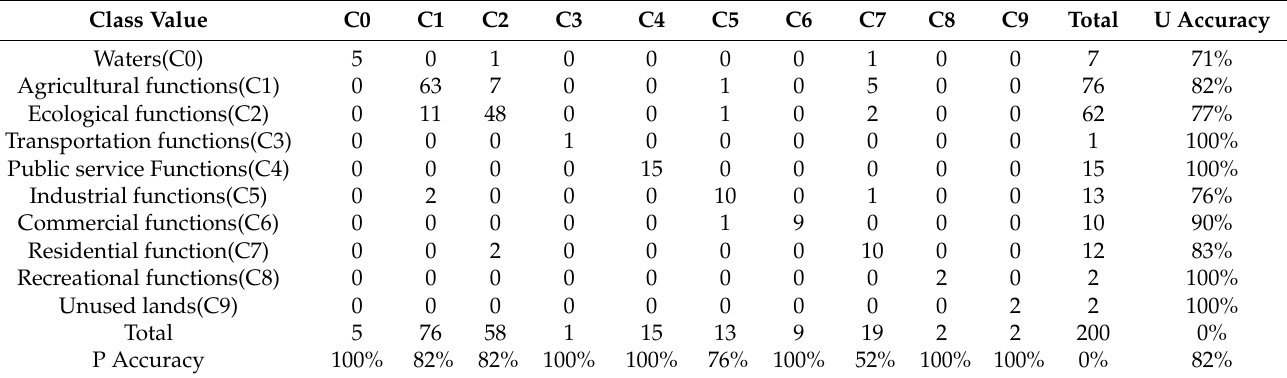
Table 4. Confusion matrix of the functional zone identification